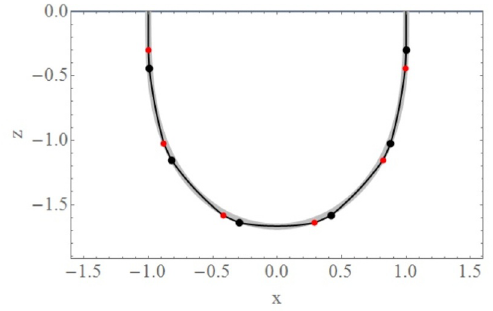
Figure 5 . Time-periodic segmented string with 12 kinks. It is an exact solution which approximates the static smooth solution in AdS (background gray curve). Black and red dots indicate left- and 3 right-moving kinks. These are connected by elementary segments (black